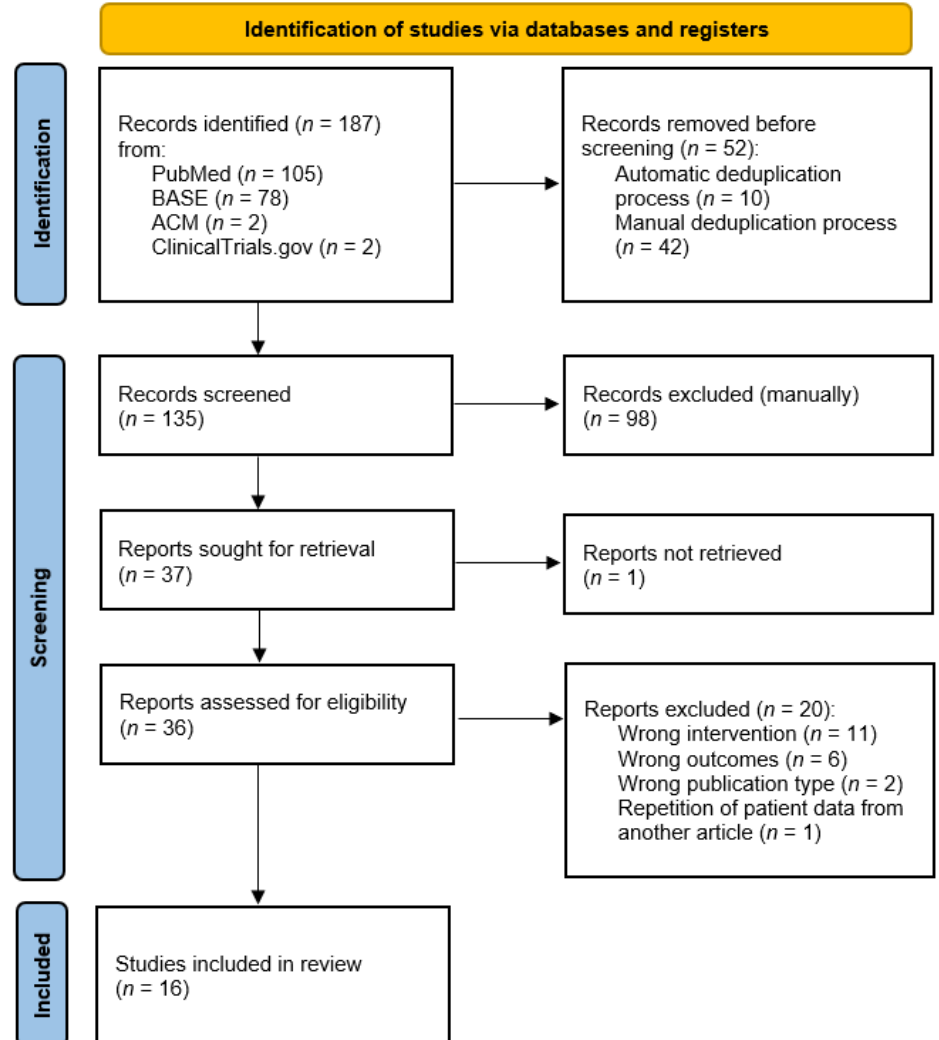
Figure 1. PRISMA flow diagram showing the stages of the studies/study selection.